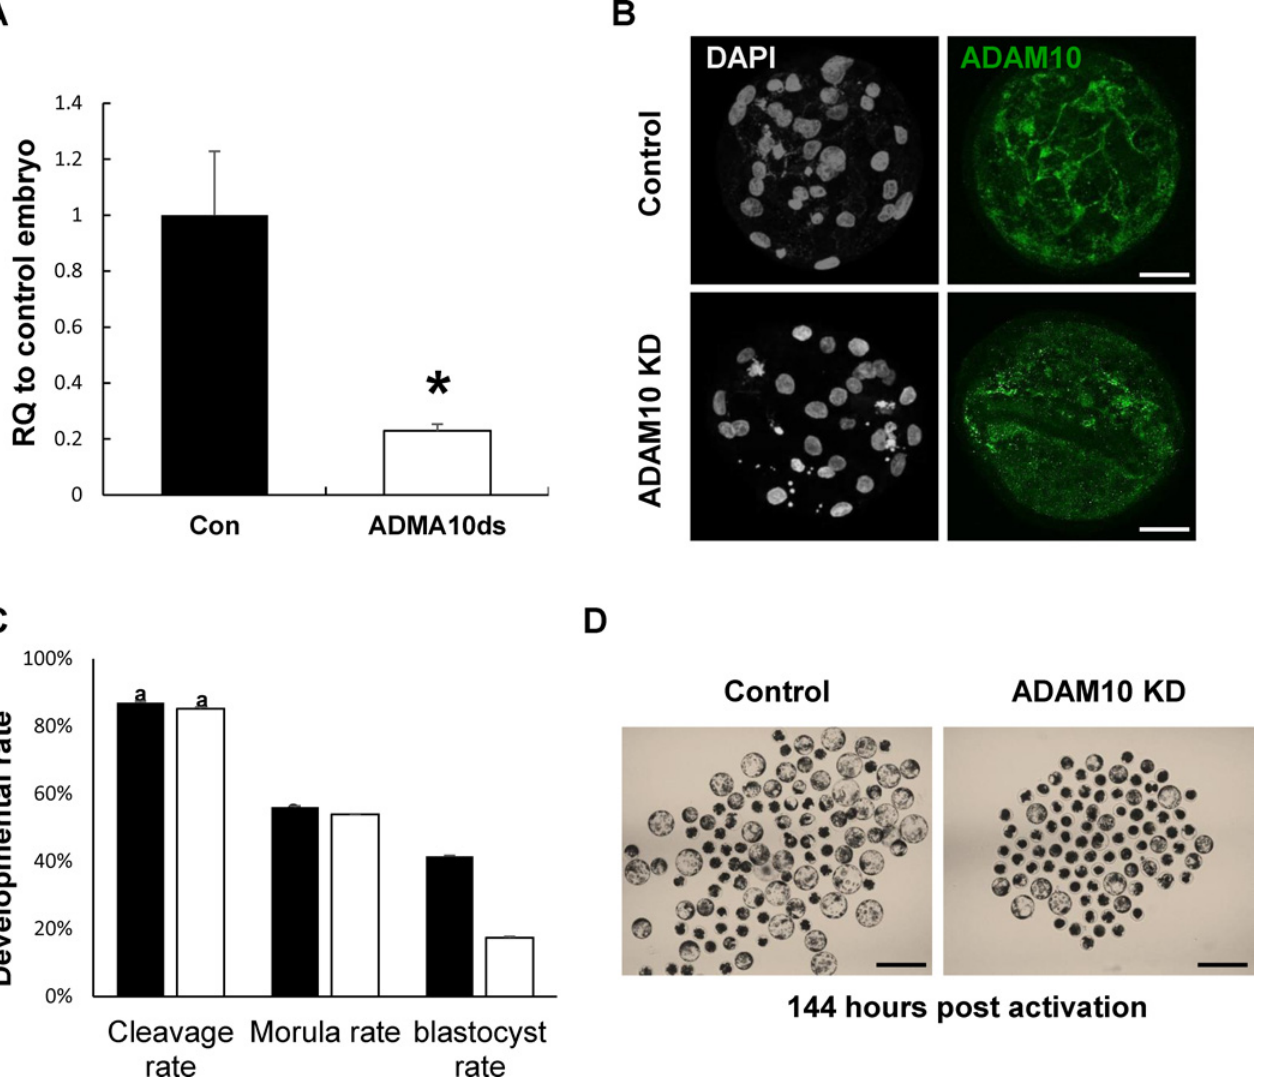
Fig 2. Knock-down (KD) of ADAM10 during early embryonic development. (A) KD efficiency of ADAM10 in blastocysts by qRT-PCR. (B) KD efficiency of ADAM10 in blastocysts by ICC. (C) Developmental competence of both control and knock-down groups. (D) Representative images of control and ADAM10 KD blastocysts at 144 h.p.a. Asterisks indicate statistically significant differences ( P < 0.05). The data are presented as mean ± SEM. RQ: relative quantification; Scale bars: 200 μ m.